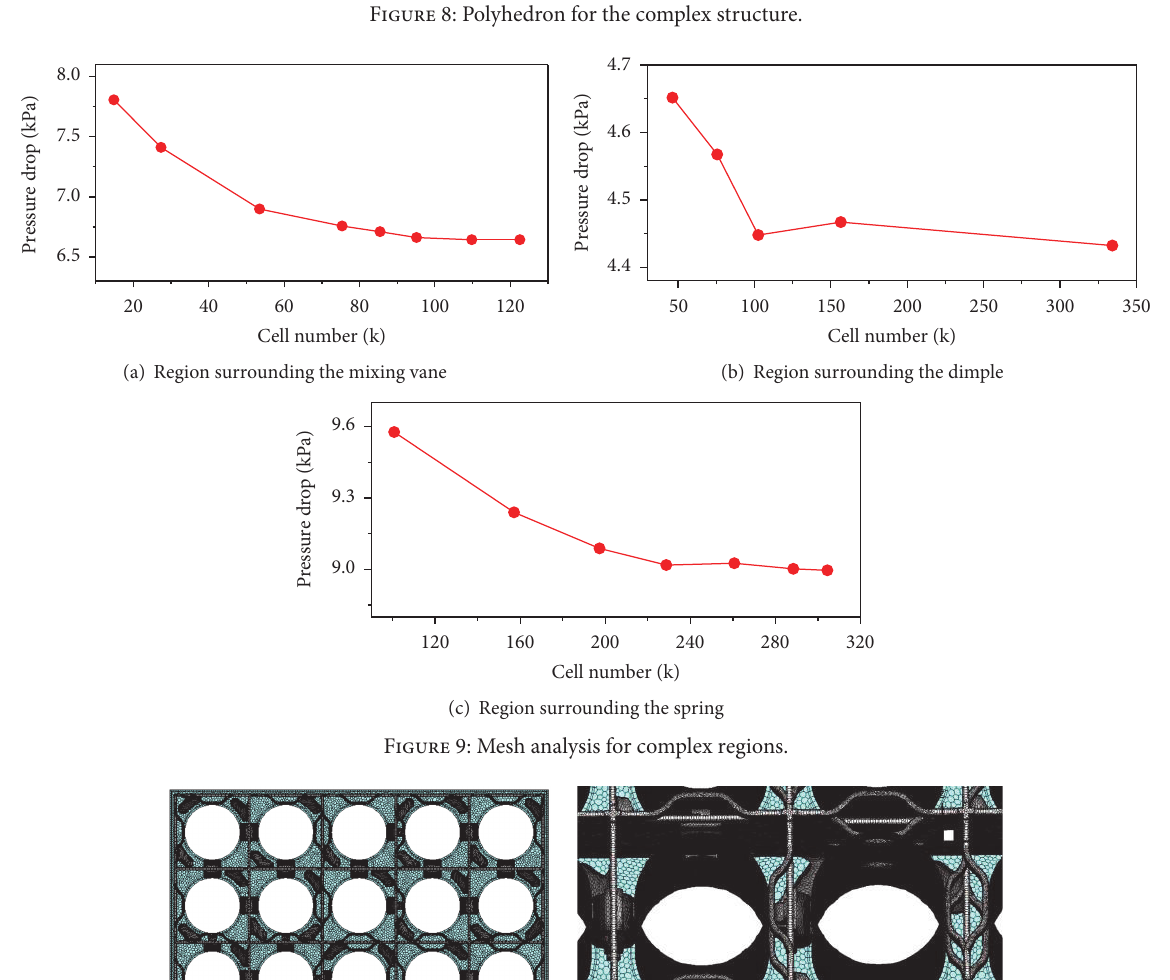
Figure 8: Polyhedron for the complex structure.